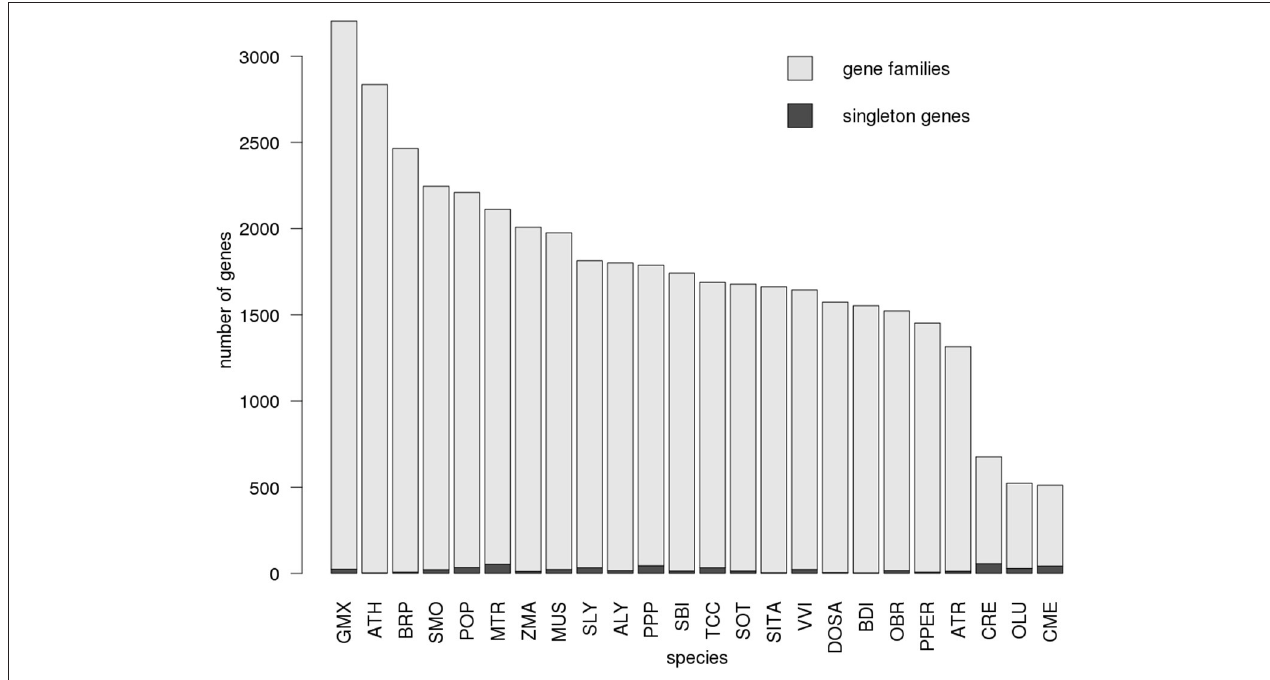
FIGURE 5 | Number of enzyme genes assigned to gene families. The proportion of genes assigned to gene families (light gray) as well as singleton genes (dark gray) is displayed for each plant species with available KEGG and gene annotation. The distribution is shown for gene family assignment based on the Network30 dataset. Species are sorted by the total number of genes. For every species, only genes annotated to function as enzymes were considered.